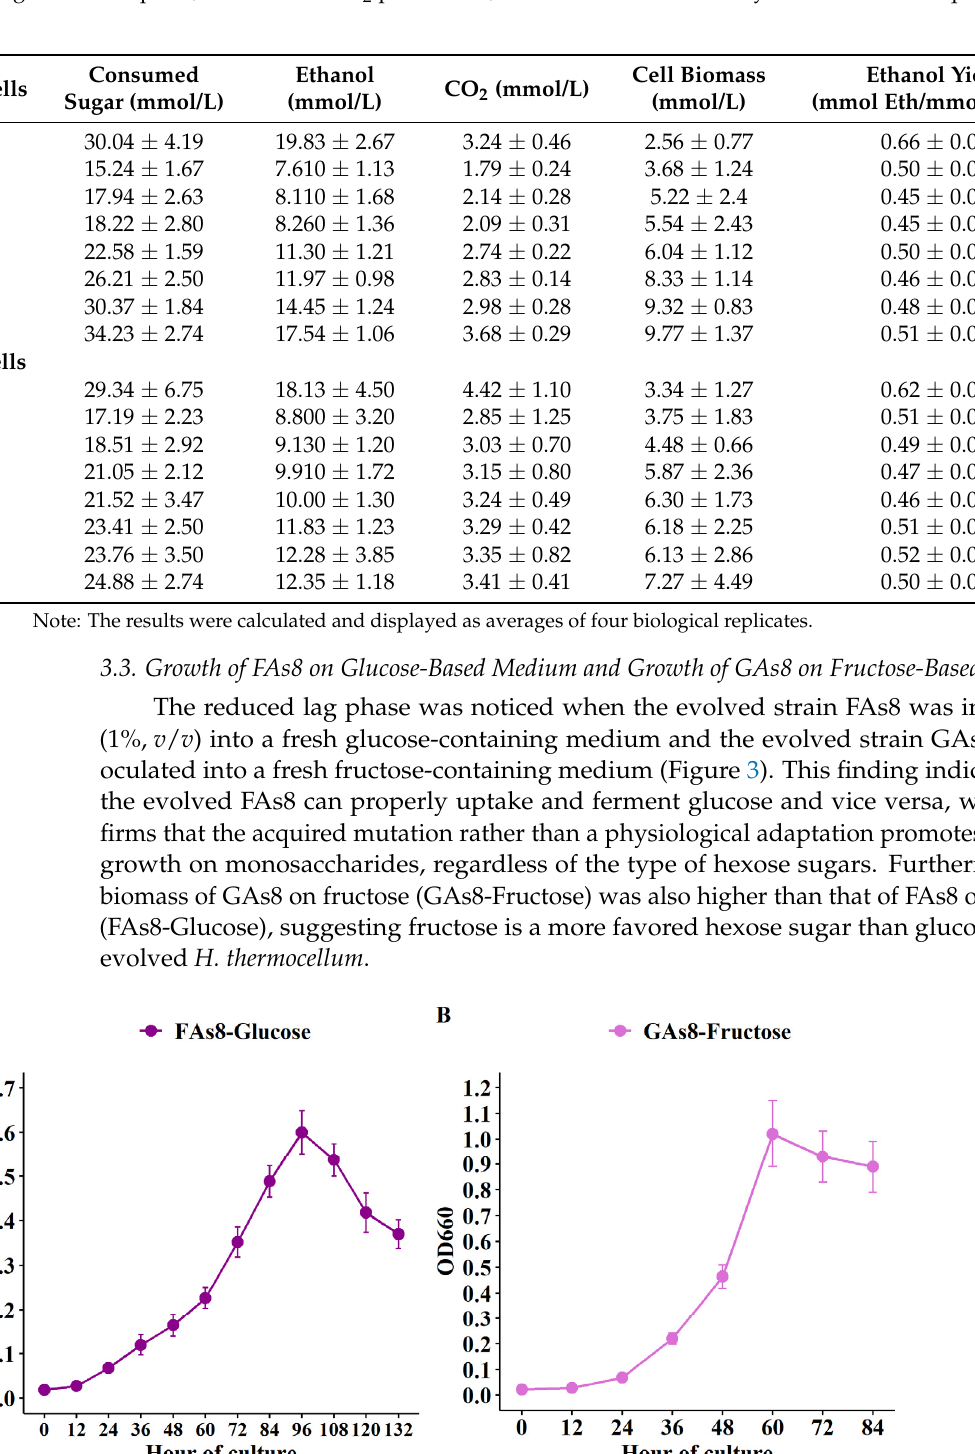
Table 1. Hexose sugars consumption, ethanol and CO 2 production, cell biomass and ethanol yield after seven sequential transfer events.